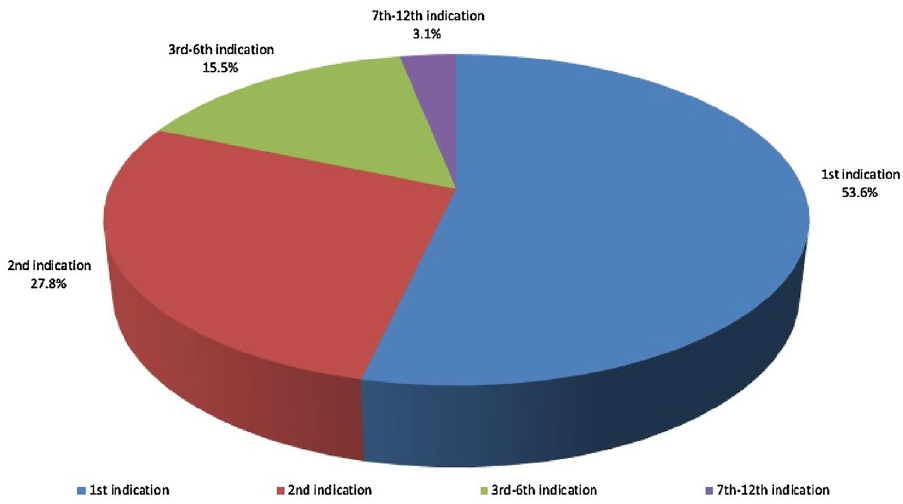
Figure 1. Correct sorting rates for a large-scale sample of 97 individuals. The methodology’s “1st indication” is considered to be the femur with the smallest shape difference (i.e., Manhattan distance; see Materials and Methods) to the examined acetabulum.